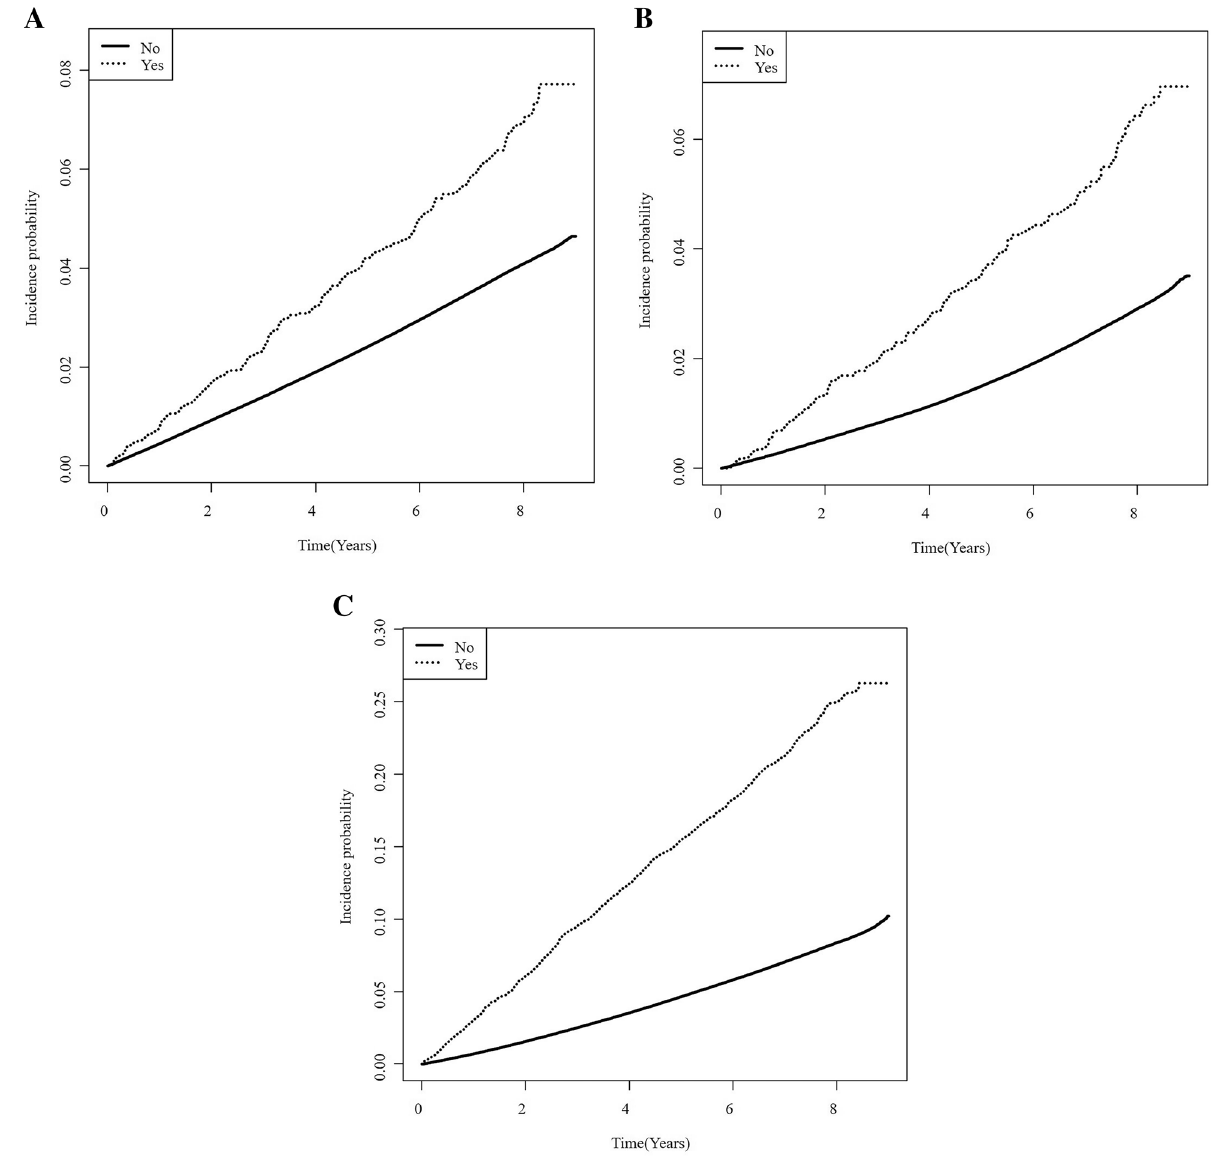
Figure 1. Kaplan–Meier curves for the risk of cardiovascular disease and mortality according to acute pancreatitis history. The curves display the cumulative incidence probability of ( A ) stroke, ( B ) myocardial infarction, and ( C )